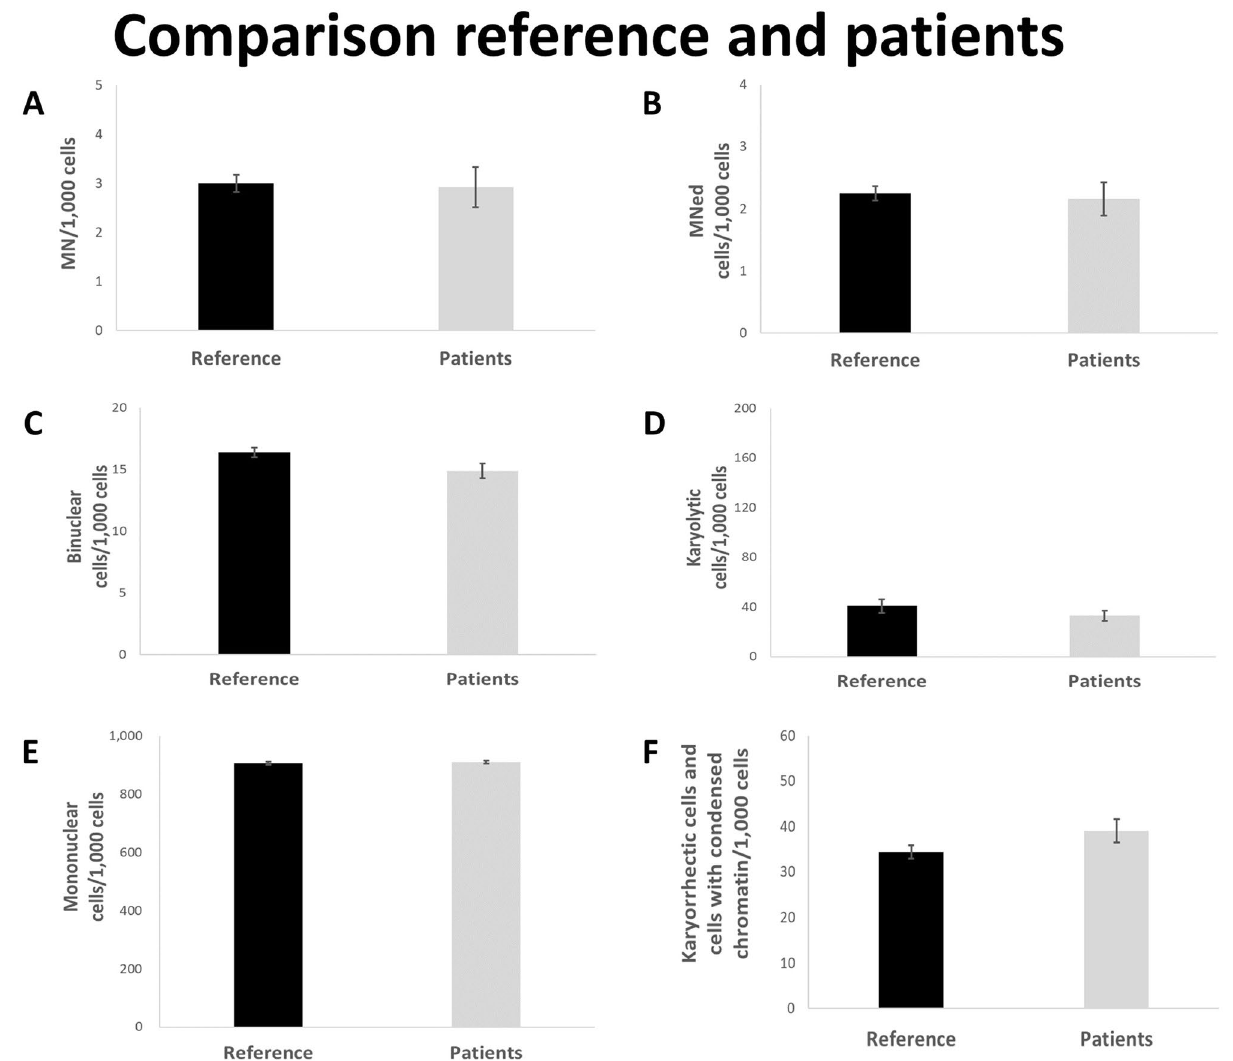
Figure 1. Rate of MN ( A ), MNed cells ( B ), binucleated cells ( C ), karyolytic ( D ), mononuclear ( E ) and karyorrhectic cells and cells with condensed chromatin ( F ) per 1000 cells. Mean of each group ± standard error. Black bars represent data from reference, grey bars represent data from patients. n (reference): 329; n (patients):